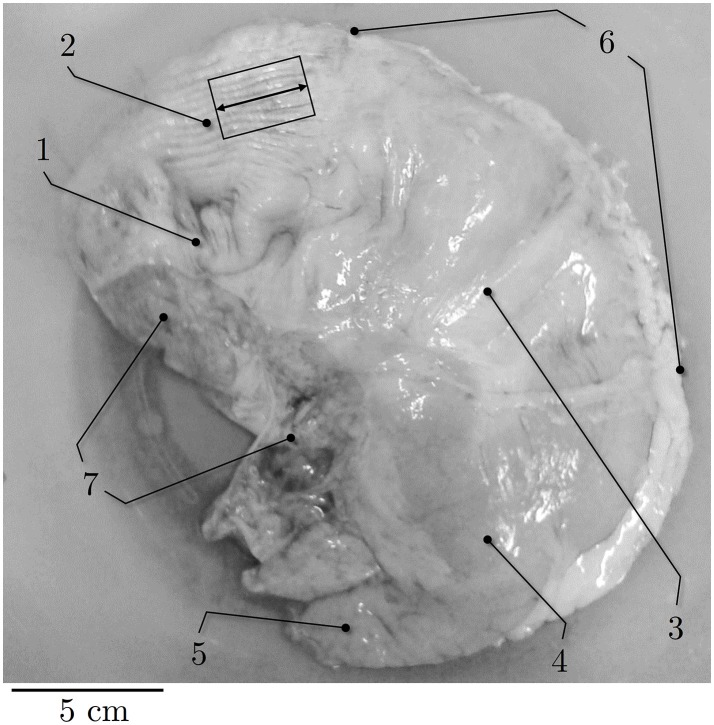
Representative picture of porcine stomach. Ventral view of external anatomy of a porcine stomach. (1) cardia, (2) fundus, (3) corpus, (4) antrum, (5) pylorus, (6) greater curvature, (7) smaller curvature. Black rectangle indicates longitudinal muscle strip dissected from the fundus. Longitudinal direction is marked by the black arrow.